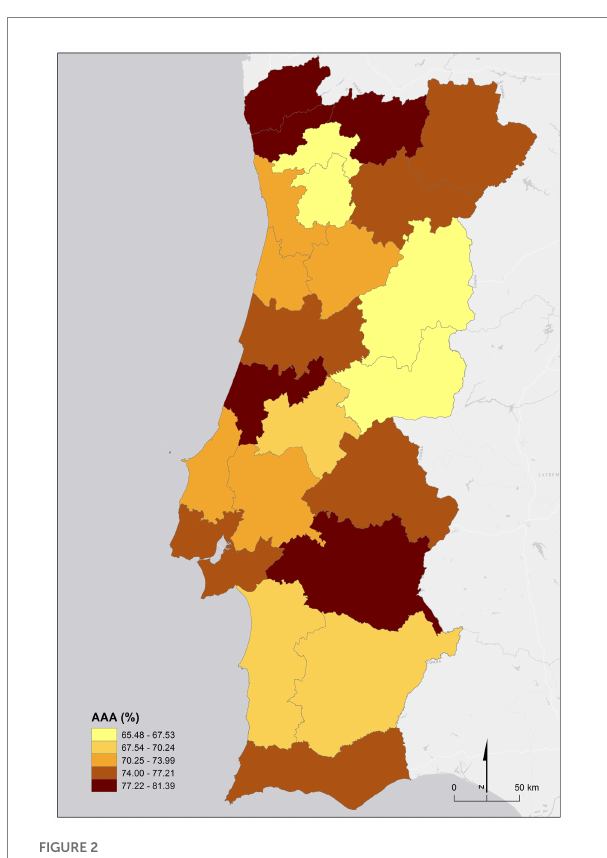
FIGURE 2 Active aging awareness scores by NUTS III